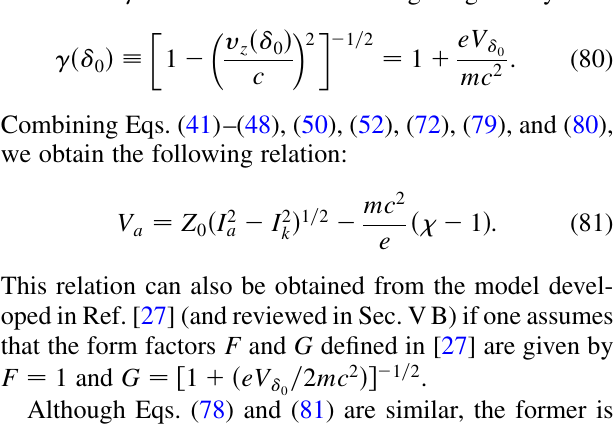
Z =V FIG. 2. (Color) The ratio I as a function of V for a a; min a a 0 (cid:14) 50 MV . The quan- 1D planar MITL, plotted for 50 kV (cid:14) V a is the minimum anode current required to establish tity I a; min magnetic insulation. The ratio is plotted for the collisional model [Eq. (58)] and four collisionless models [Eqs. (75), (76), (78), and (81)]. Equation (75) is obtained by Creedon [8,9], Eq. (76) by Mendel, Seidel, and Rosenthal [27], and Eq. (78) by Miller and Mendel [30]. [Eq. (81) is obtained in the present article.] * 1 MV , experimentally observed values of I are When V a a; min expected to fall between the collisional and collisionless